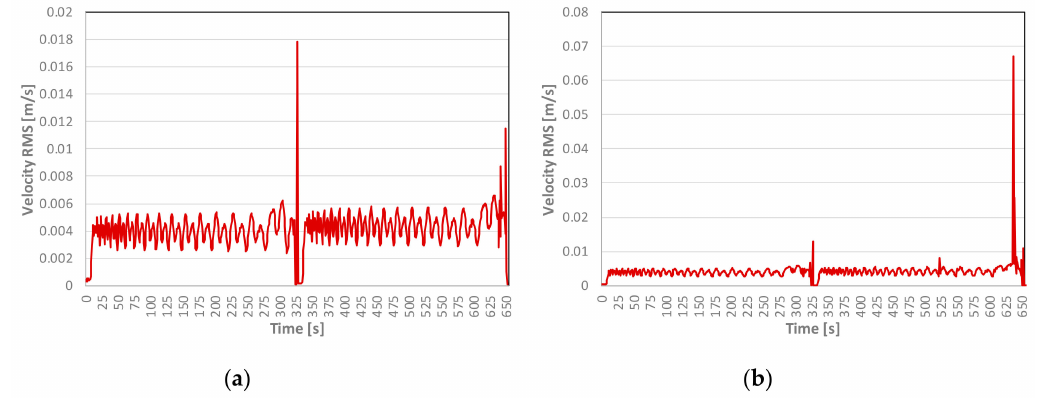
Figure 13. Vibrations amplitude on CVD coated inserts for ( a ) PH5740-L1 and ( b ) PH5740-L2 cutting inserts tests.